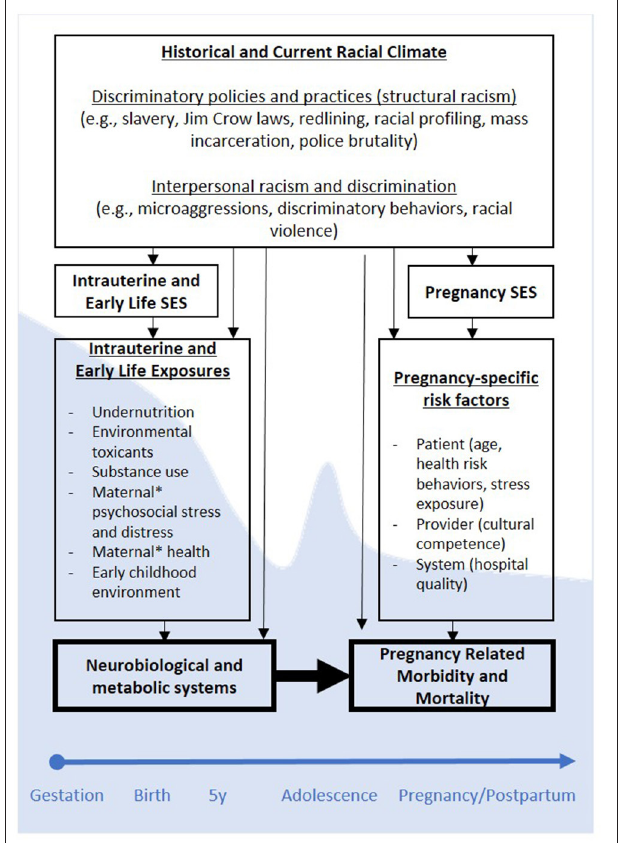
FIGURE 1 | Conceptual Model of Developmental Origins of Black PRMM. *Maternal refers to women’s biological mothers. SES, socioeconomic status; PRMM, pregnancy-related mortality and morbidity. Programming effects as hypothesized using a DOHaD framework are depicted across one generation, but may be cyclical across generations (e.g., generation 1 PRMM may contribute to programming of generation 2 neurobiological and metabolic systems, etc.). Shaded (blue) backdrop corresponding to different developmental periods indicates neuroplasticity, and degrees to which stress exposures during those periods may prompt programming